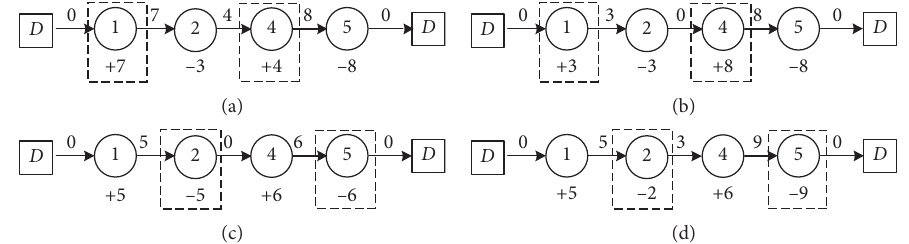
Figure 4: Neighbor solutions after applying the adjustment operator between two pickup-delivery pairs. (a) Adjustment of the loading quantities between station 1 and station 4. (b) Adjustment of the loading quantities between station 1 and station 4. (c) Adjustment of the unloading quantities between station 2 and station 5. (d) Adjustment of the unloading quantities between station 2 and station 5.